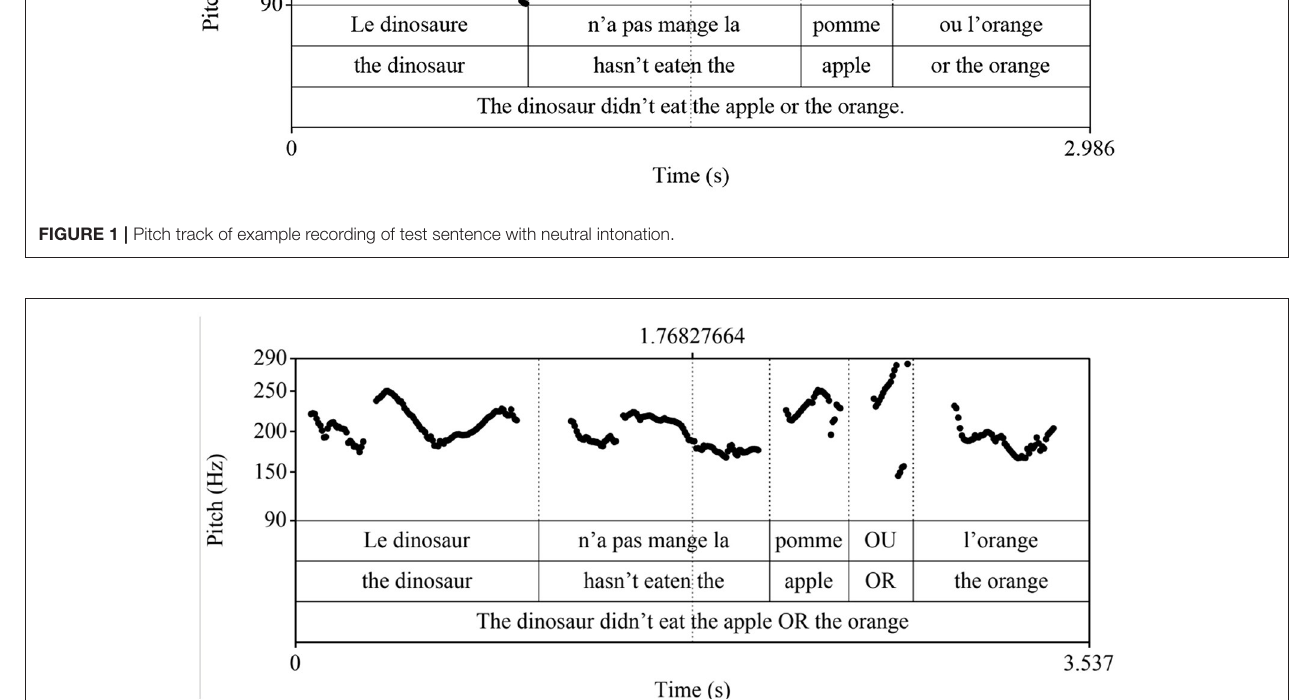
FIGURE 2 | Pitch track of example recording of test sentence with focal stress on disjunction.